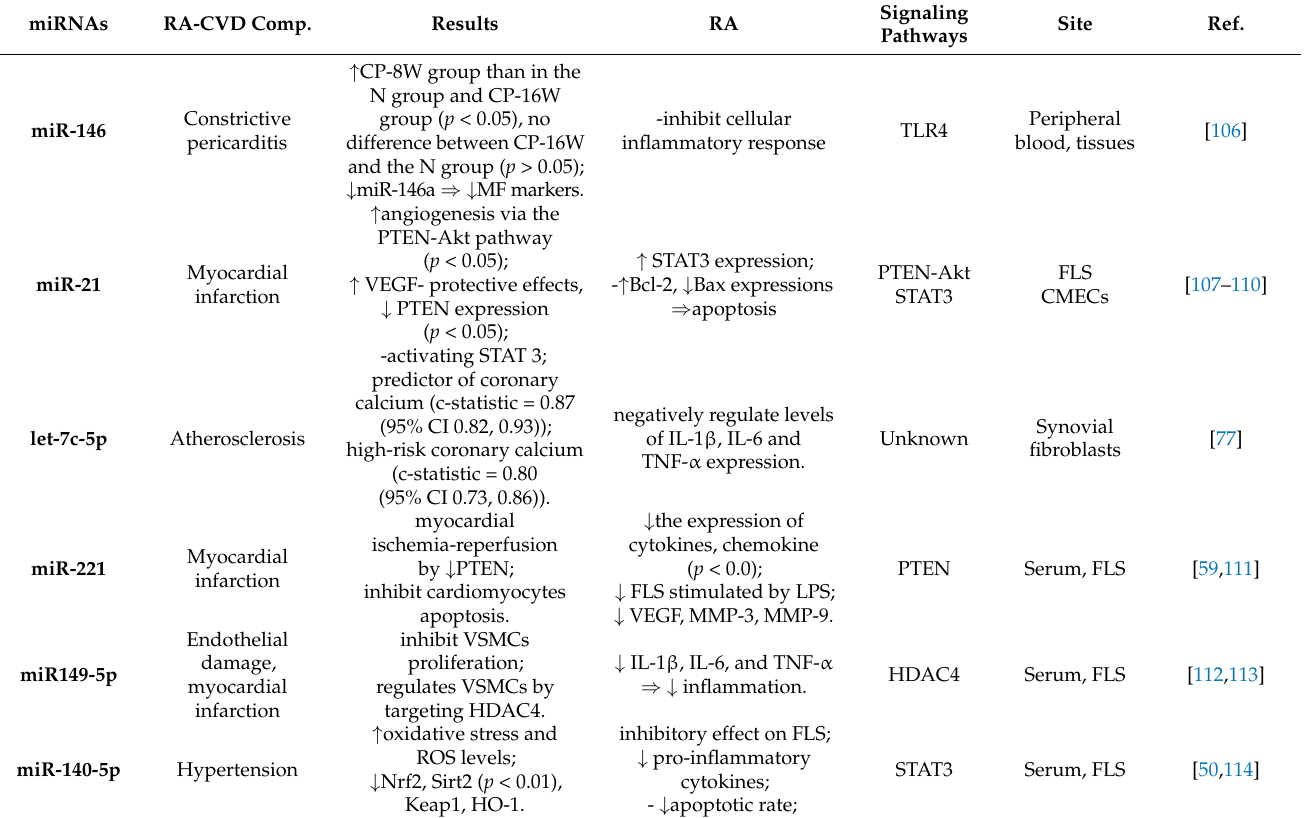
Table 2. miRNAs and their role in RA-CVD complications. Constrictive pericarditis (CP); rats group raised 8 weeks (CP-8W); 16 weeks group (CP-16W); normal group (N); Toll-like receptor 4 (TLR4); protein kinase B (Akt); the phosphatase and -tensin homolog (PTEN); signal Transducer And Activa- tor Of Transcription 3 (STAT3); apoptosis Regulator (BCL2); bcl-2-like protein 4 (bax); fibroblast-like synovial cells (FLS); cardiac microvascular endothelial cells (CMECs); lipopolysaccharide (LPS); ma- trix metalloproteinase-3 (MMP-3); Interleukin-1 (IL-1 β ); vascular endothelial growth factor (VEGF); matrix metalloproteinase (MMP-9); vascular smooth muscle cells (VSMCs); histone deacetylase 4 (HDAC4); nuclear factor erythroid 2-related factor 2 (Nrf2); sirtuin 2 (Sirt2); kelch-like enoyl-CoA hydratase-associated protein 1 (Keap1); heme oxygenase 1 (HO-1); pulse wave velocity (PWV); ery- throcyte sedimentation rate (ESR); C-Reactive Protein (CRP); Disease Activity Score (DAS/DAS28); carotid intima-media thickness test (cIMT); the α -chemokine receptors (CXCR); lower ( ↓ ); raised ( ↑